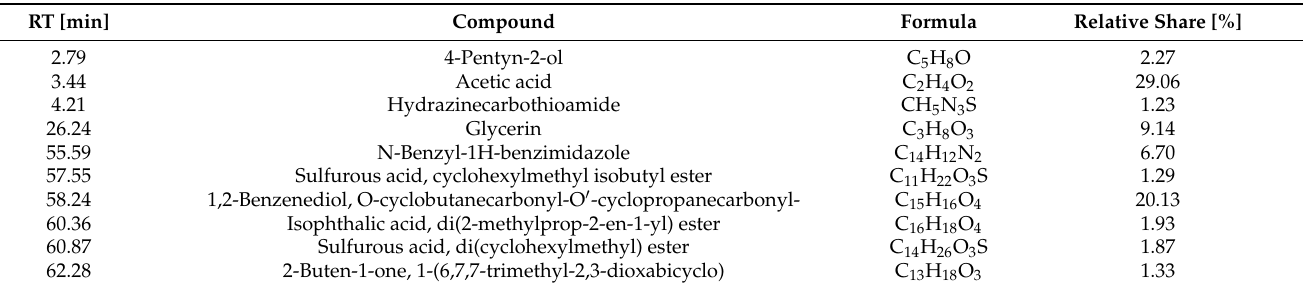
Table 5. Exemplary compounds identified as aqueous phase organics at 300 ◦ C and a biomass-to- solvent ratio of